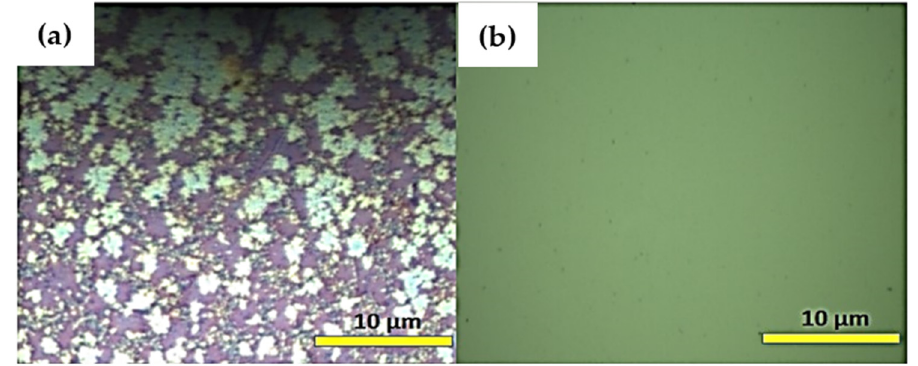
Figure 3. ( a ) MoS 2 and ( b ) WS 2 thin-film optical microscopy images.